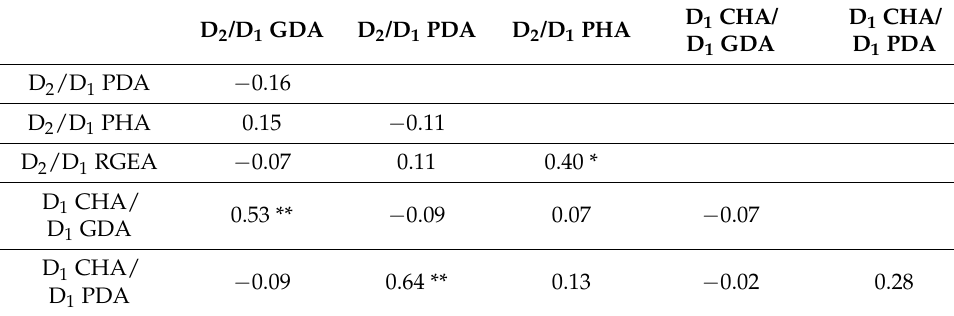
Table 8. The Spearman correlation dependence between arterial geometry